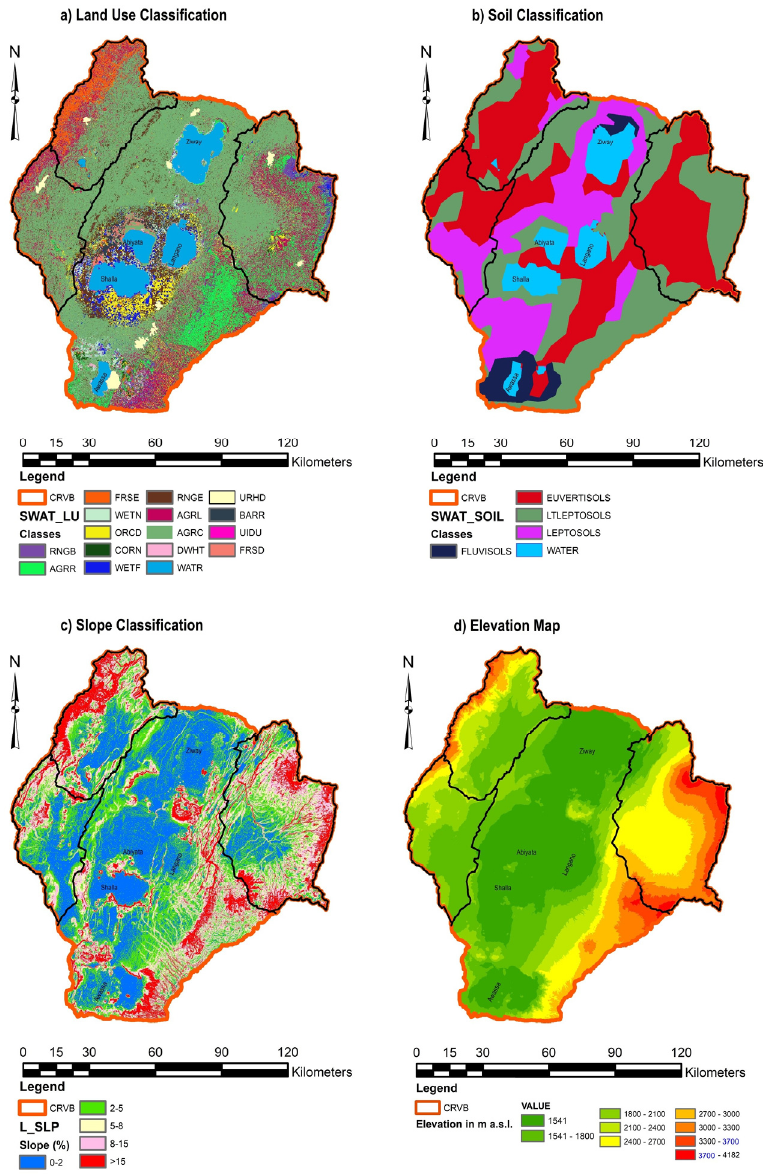
Figure 2. Distributions of land use, soil, slope, and elevation ranges in the CRVB (Note: the land use and soil codes are according to the SWAT classification standard as indicated in Tables S1 and S3 in the Supplementary File).